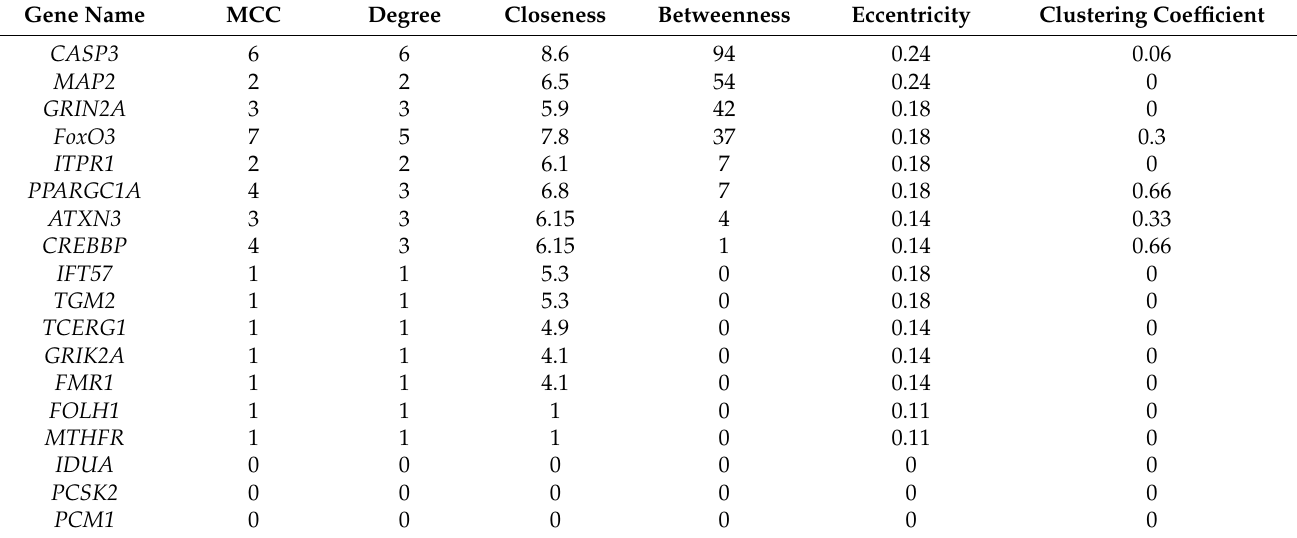
Table 5. The ranking hub genes identified by Cytohubba for the six network scoring measures of the 18 HD-related hub PPI